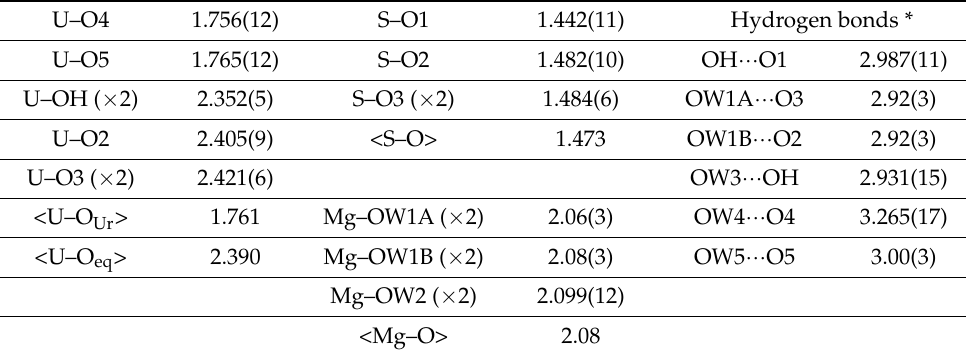
Table 5. Selected bond distances (Å) for